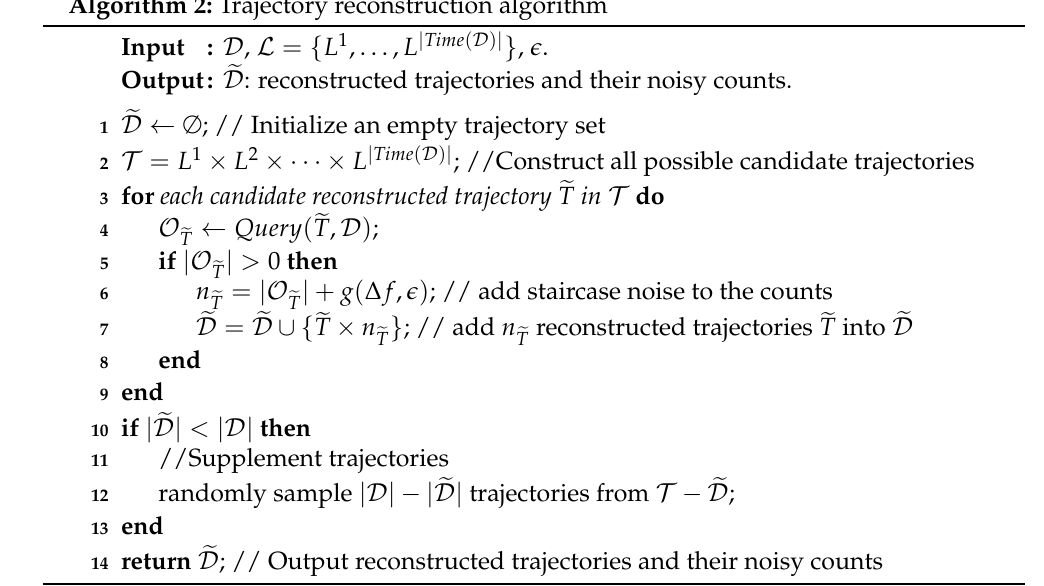
Algorithm 2: Trajectory reconstruction